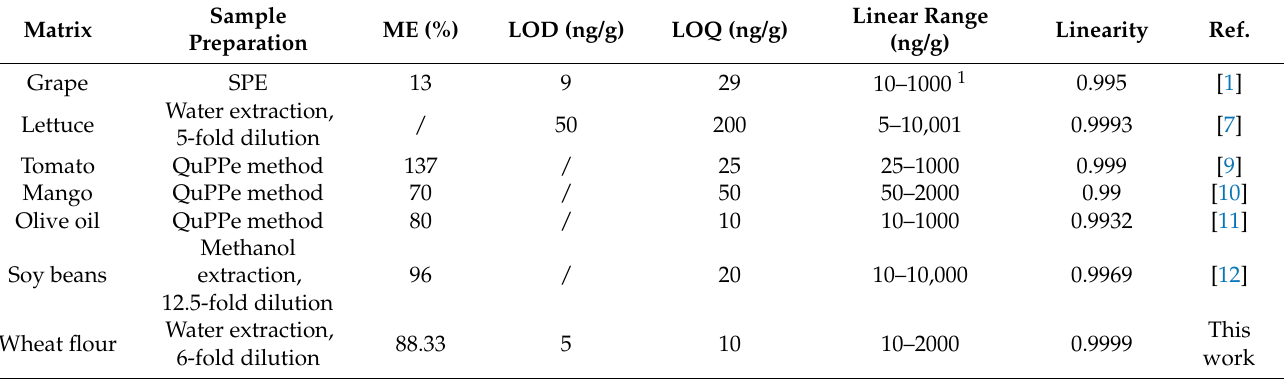
Table 2. Method comparison of fosetyl-Al in different